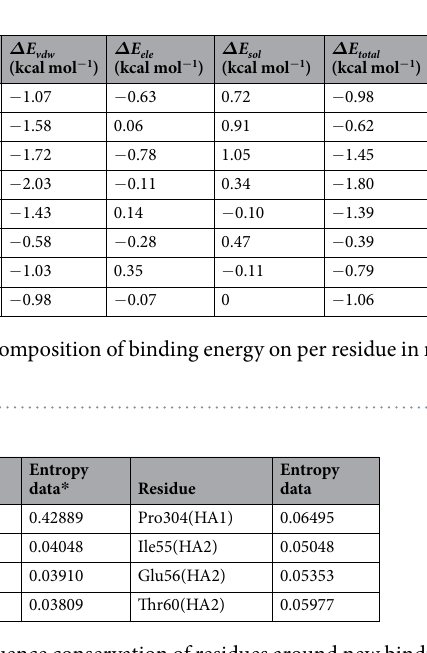
Table 5. Sequence conservation of residues around new binding site evaluated by sequence alignment for different H1N1 influenza virus strains in recent 30-year period of time. * low entropy data means high